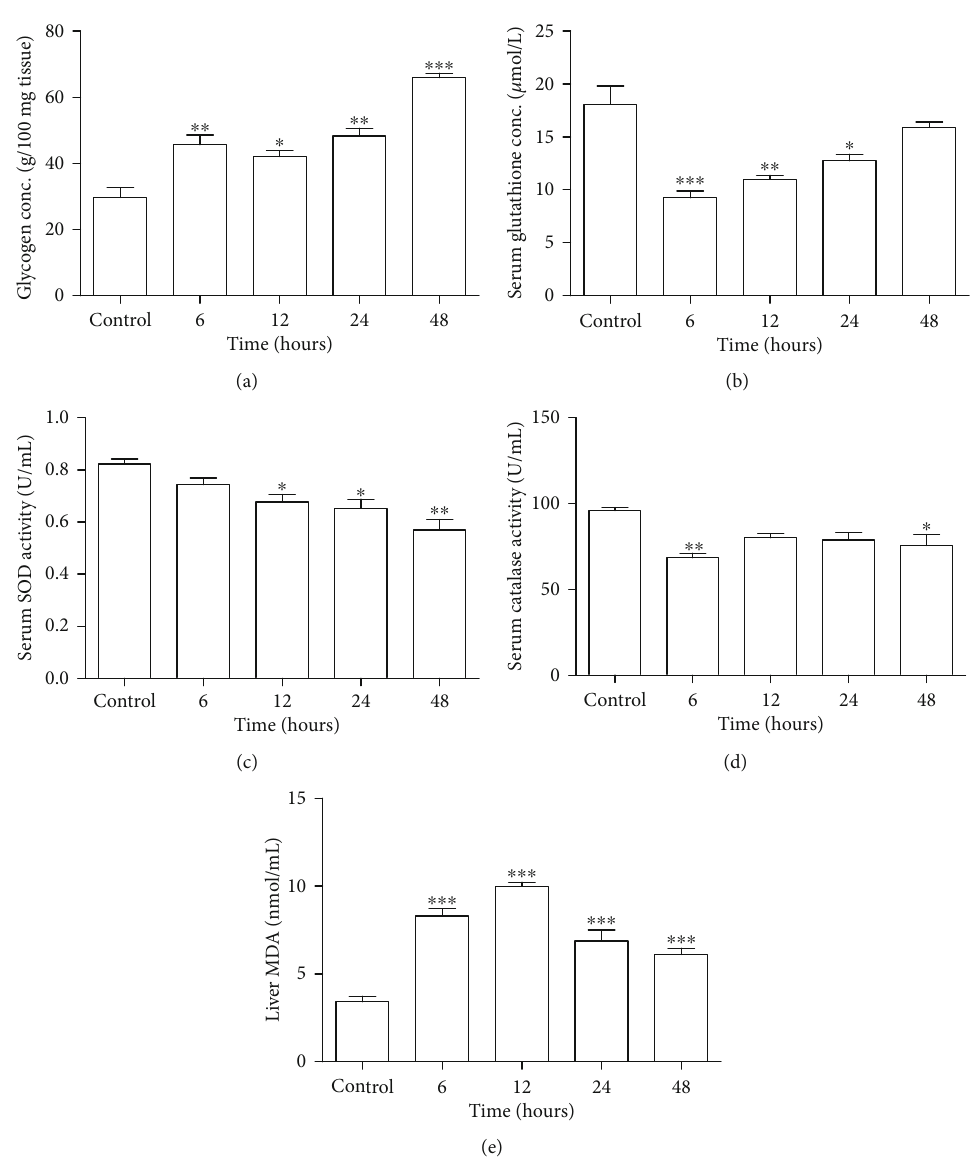
Figure 2: E ff ect of short-term Tacrolimus exposure on concentration of glycogen in liver tissue, serum antioxidants, and liver MDA level. (a) Increased glycogen in liver tissue homogenate is shown in graphical representation depicting the concentration measured in g/100mg of tissue in control, 6-, 12-, 24-, and 48-hour treatment groups. Data is represented as mean ± SEM ( n = 6 ). ∗ P ≤ 0 : 05 , ∗∗ P ≤ 0 : 01 , and ∗∗∗ P ≤ 0 : 001 . Serum antioxidant status and tissue MDA level are shown in graphical representation in control, 6-, 12-, 24-, and 48-hour treatment groups. (b) GSH concentration, (c) SOD activity, (d) CAT activity, and (e) MDA level. Data is represented as mean ± SEM ( n = 6 ). ∗ P ≤ 0 : 05 , ∗∗ P ≤ 0 : 01 , and ∗∗∗ P ≤ 0 : 001